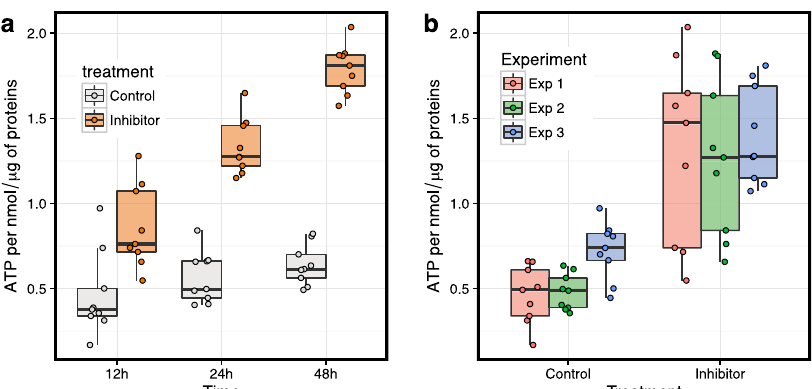
inhibitor vs. control). Samples were normalized to the amount of residual protein (see “ Methods ” for details). Each boxplot displays the median (middle line), the fi rst and third quartiles (lower and upper hinges) and the most extreme values no further than 1.5* the interquartile range from the hinge (upper and lower